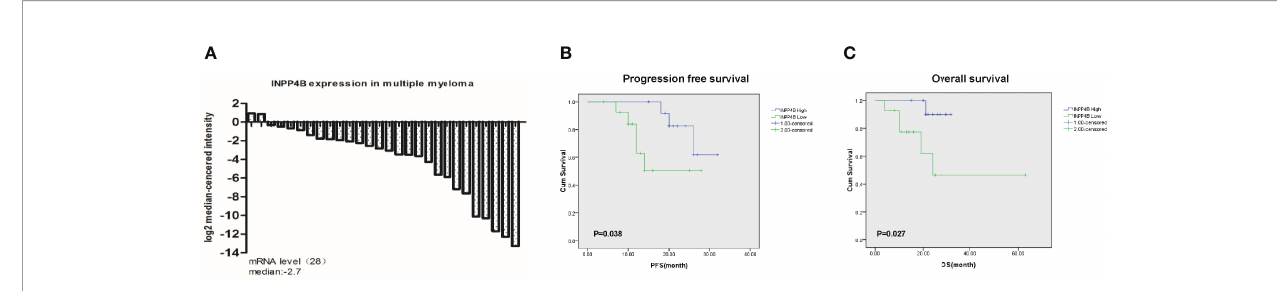
FIGURE 1 | Expression of INPP4B in MM patient samples. (A) The expression level of INPP4B in newly diagnosed MM patient samples. (B) Correlation of INPP4B expression with progression-free survival (PFS) and (C) overall survival (OS) in patients with newly diagnoses MM patients.